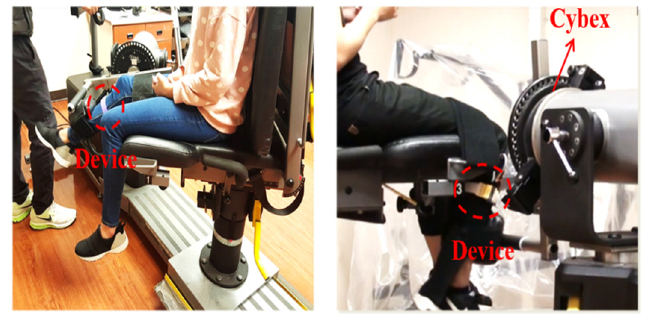
Figure 14. Experimental setup.